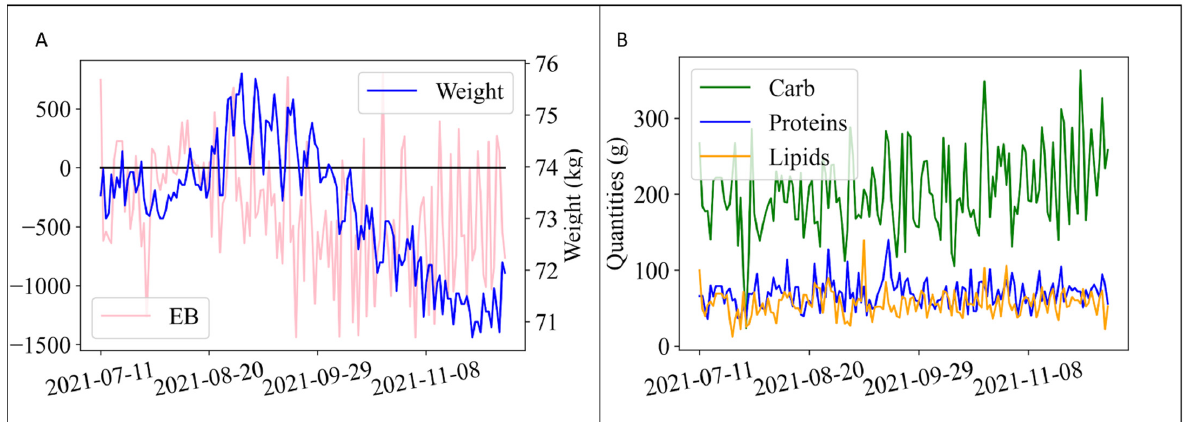
Figure 1. Time series describing user metabolism. ( A ) Representative time series for weight and EB. ( B ) Representative time series for food composition.